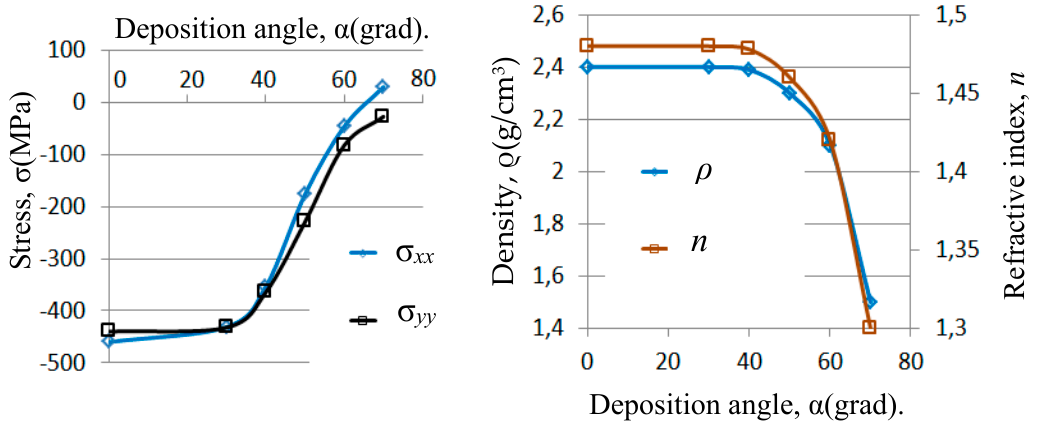
Figure 6. Dependences of the stress tensor components, film density, and refractive index on the deposition angle.